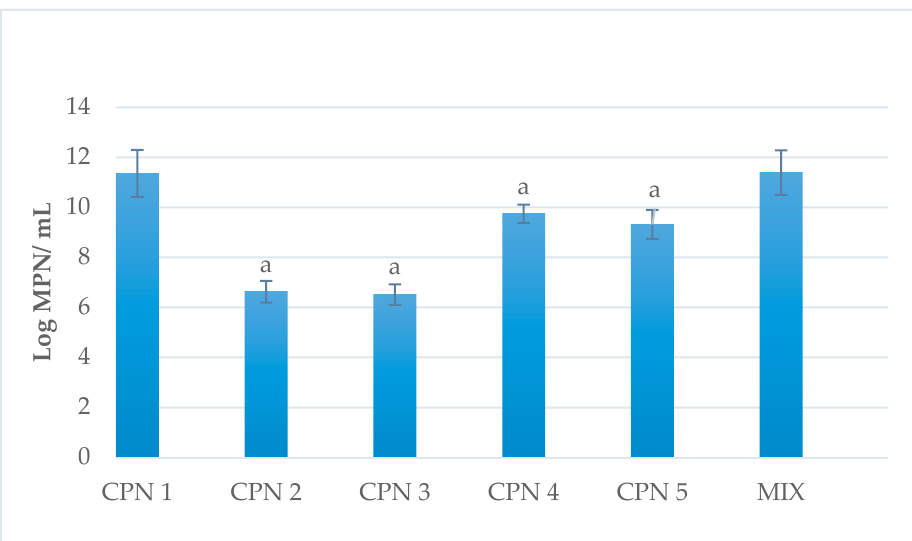
Figure 1. Abundance of hydrocarbons degraders, evaluated by the most-probable number (MPN) method, in the cultures inoculated with the bacterial strains isolated from a beach sediment, both as individual bacterial strains (CPN1, CPN2, CPN3, CPN4, CPN5) and as a mixture of the 5 bacterial strains (MIX) (mean values, standard deviations, n = 3). a—significant differences compared with the MIX ( p < 0.05).